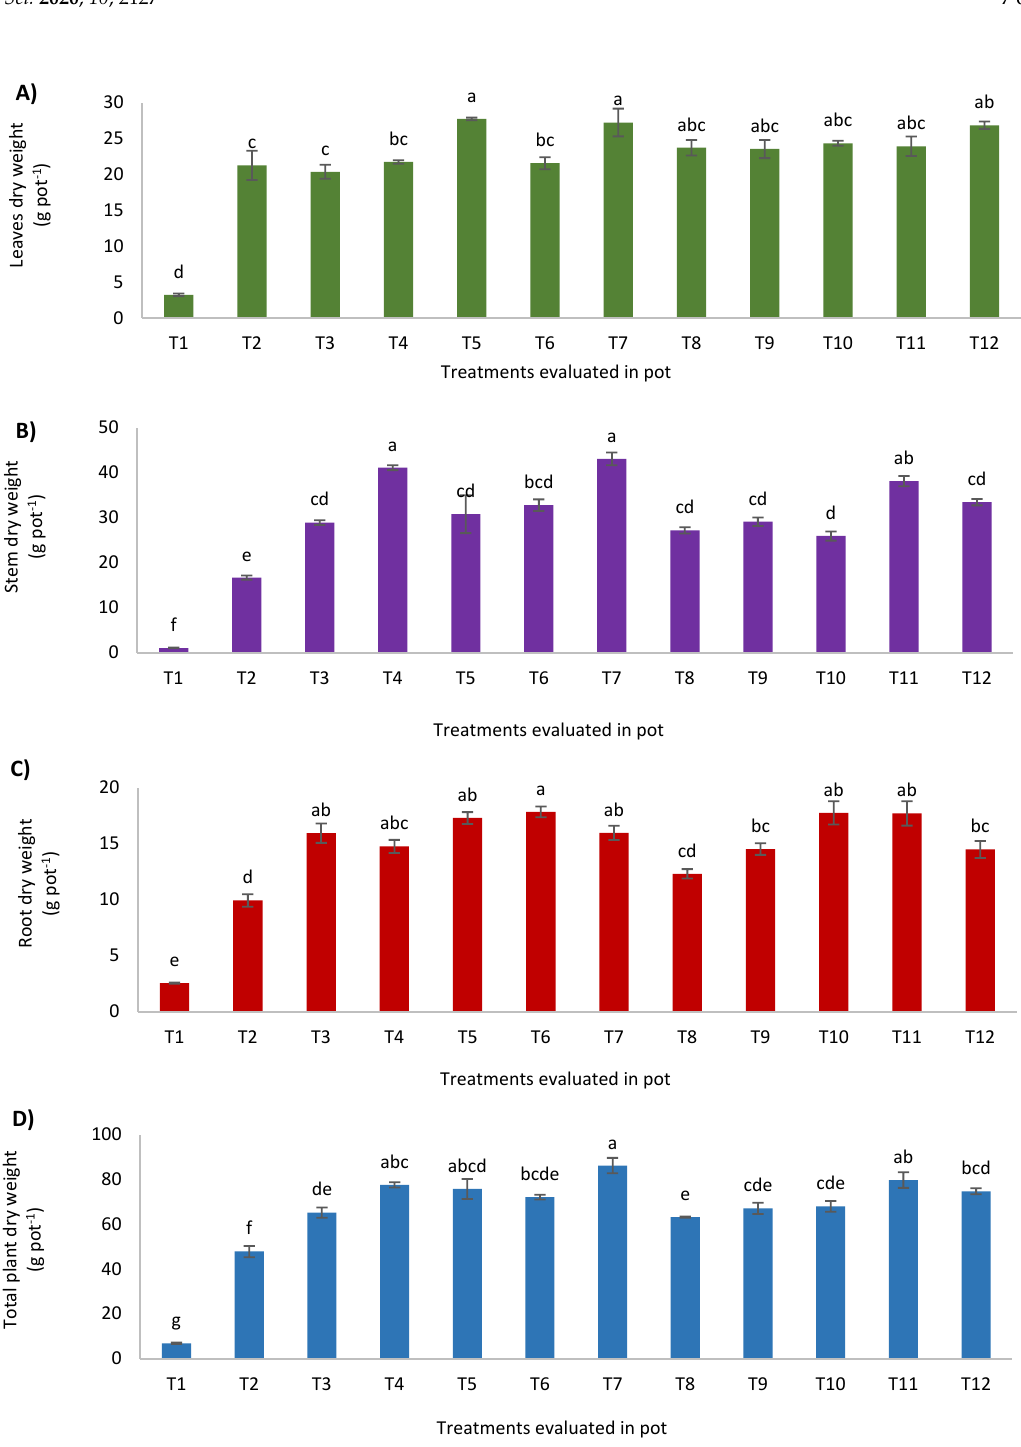
Figure 1. Effects of treatments on dry weight of ( A ) leaves; ( B ) stems; ( C ) roots; and ( D ) total dry matter yield of maize at tasseling stage. Different letters indicate significant difference between means using Tukey’s HSD (Honestly Significant Difference) test at p ≤ 0.05. The error bars are the ± standard error of triplicates.